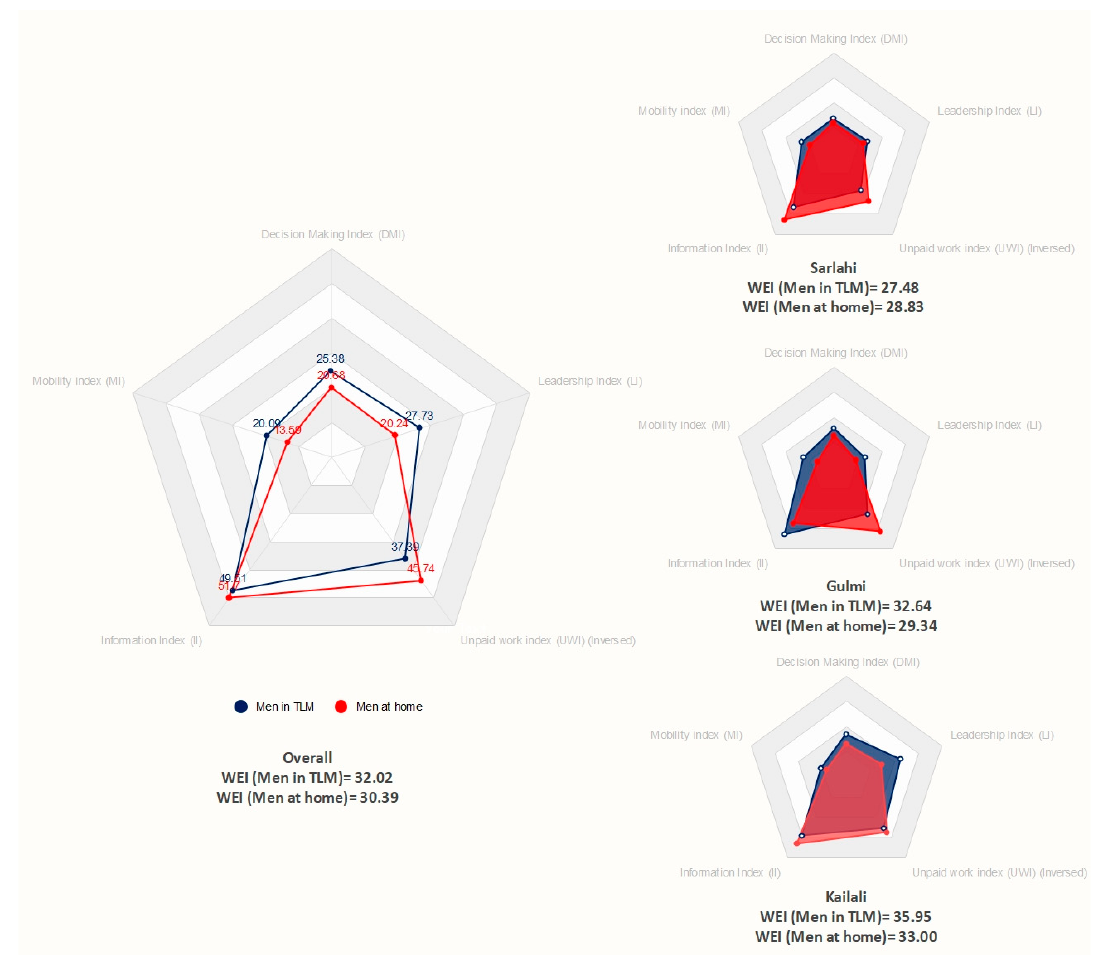
Figure 5. Radar diagram illustrating the comparison of WEI and WEI components across the study area and migration status of men.